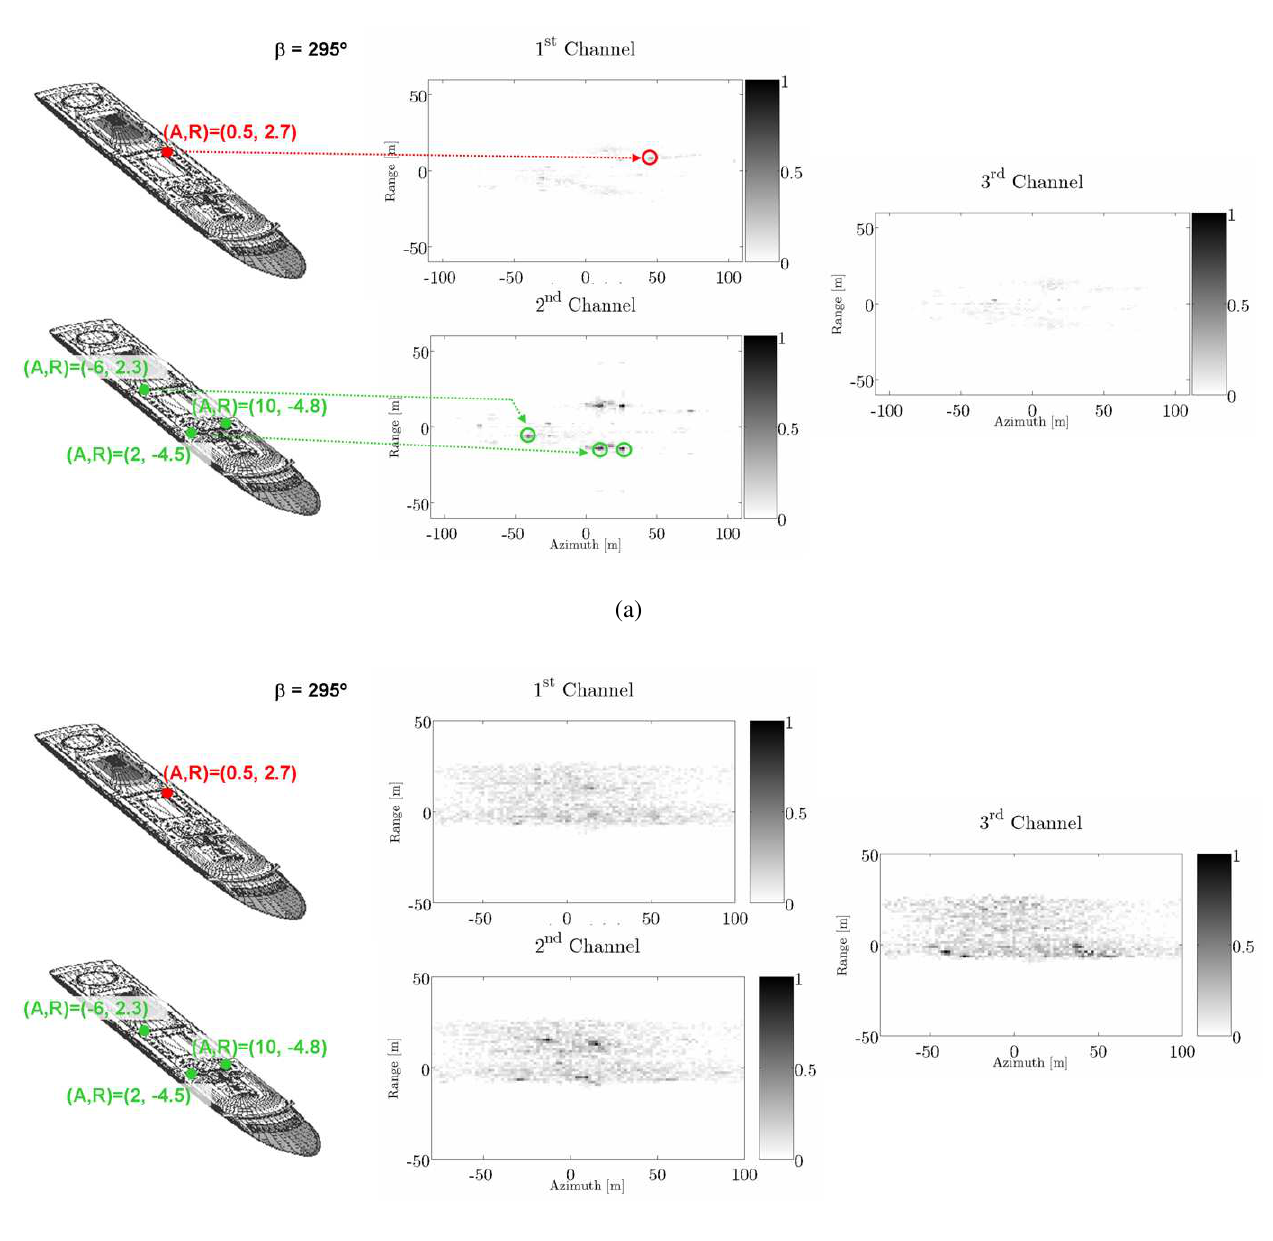
Figure 8. Magnitudes of the Pauli interferograms normalized to the overall maximum ob- tained for the FER model with β = 295 o and φ = 20 o in scenario 1 (a) and 3 (b). Both images present a snapshot of the point of view with transparent surfaces. They have su- perimposed colored points that locate the azimuth x slant-range positions of the four PePS defining the feature set of FER ship, as stated in Table 1. Note how the presence of the sea distorts the ship signature making PePS isolation by simple eye inspection (colored arrows) more